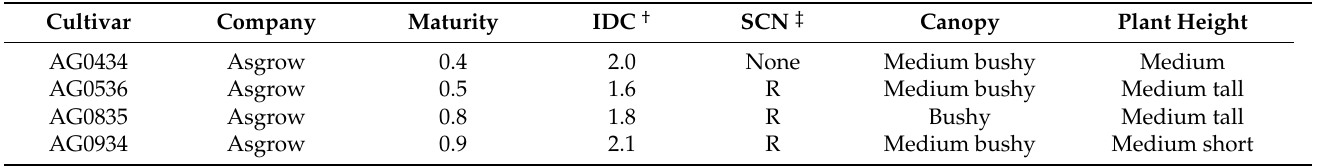
Table 1. Details of soybean cultivars used in experiments in 2016 and 2017 at Fargo, ND, USA. Cultivar Company Maturity IDC † SCN ‡ Canopy Plant